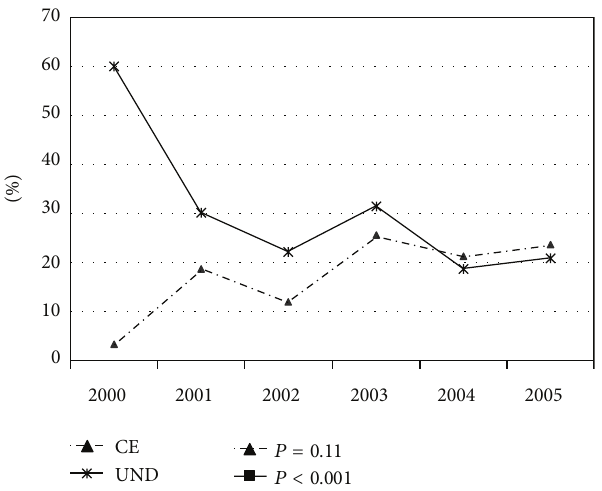
Figure 3: : TOAST classification: changes over time (2000–2005) of undetermined and cardioembolic